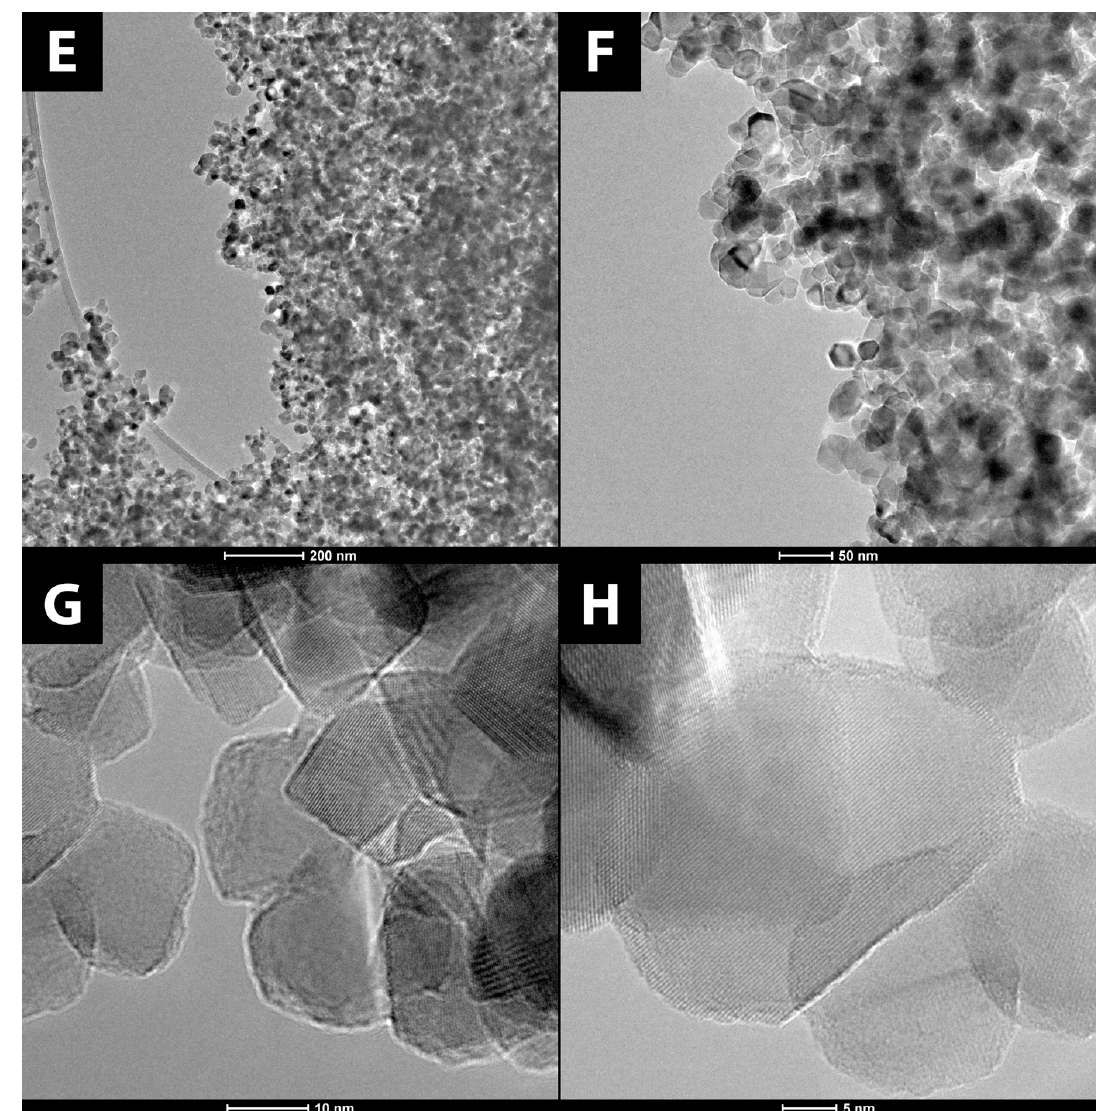
Figure 2. TEM images of ( A – D ) TiO 2 and ( E – H ) TiO 2 -GA. Further application of the HR-TEM technique allowed for capturing selected-area diffraction (SAED) patterns shown in Figure 3. Reflections specific to anatase and rutile [35] are presented on the diffractograms and correspond with the reflections observed in the X-ray powder diffraction (XRPD) measurements.